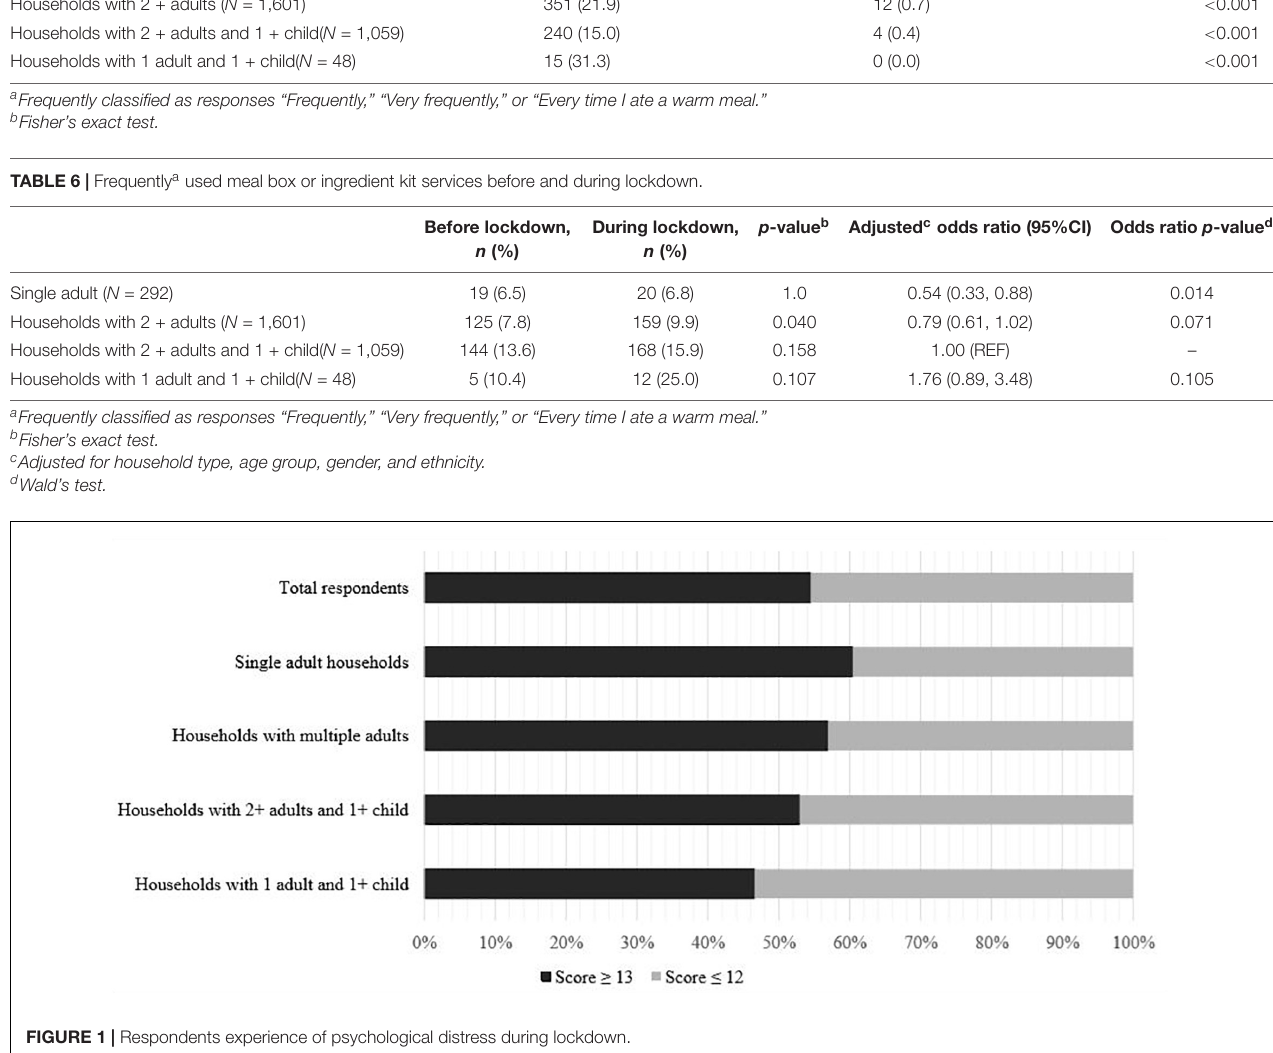
Table 7 details associations between psychological distress and mealtime behaviors by household type. In households with multiple adults but no children, those with psychological